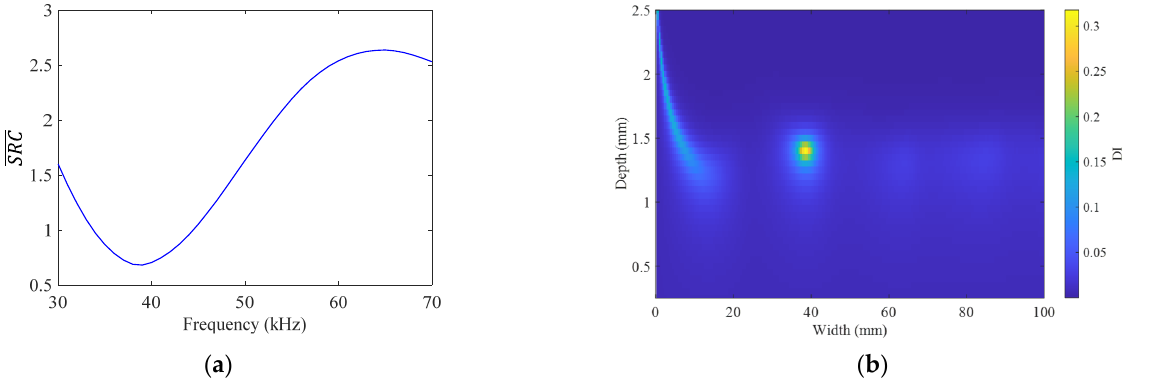
Figure 14. ( a ) Variation of the 𝑆𝑅𝐶(cid:3364)(cid:3364)(cid:3364)(cid:3364)(cid:3364)(cid:3364) with respect to frequency and ( b ) damage image result for the 40 mm-wide and 1.5 mm-deep defect.